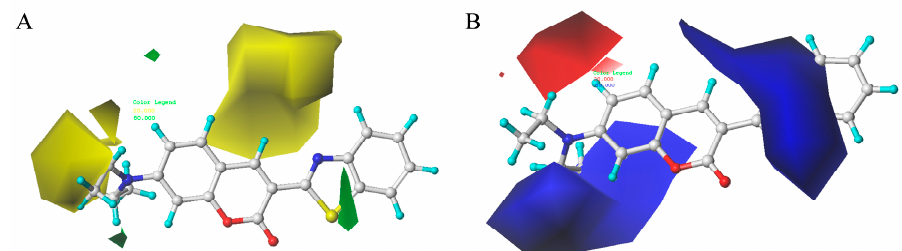
Figure 11. Steric ( A ) and electrostatic ( B ) contour maps obtained using CoMFA-derived models based on molecule 2. Green regions ( A ) indicates regions where the introduction of a bulky group would increase activity. Yellow regions ( A ) indicates regions where the introduction of a bulky group would decrease activity. Red regions ( B ) indicates regions where the introduction of electronegative groups is favored. Blue regions ( B ) indicates regions where the introduction of electropositive groups is favored. The others in Figure A and B represent the compound 2 (Red, oxygen atoms; yellow and blue, nitrogen atom; cyan, hydrogen atom; gray, carbon atoms).